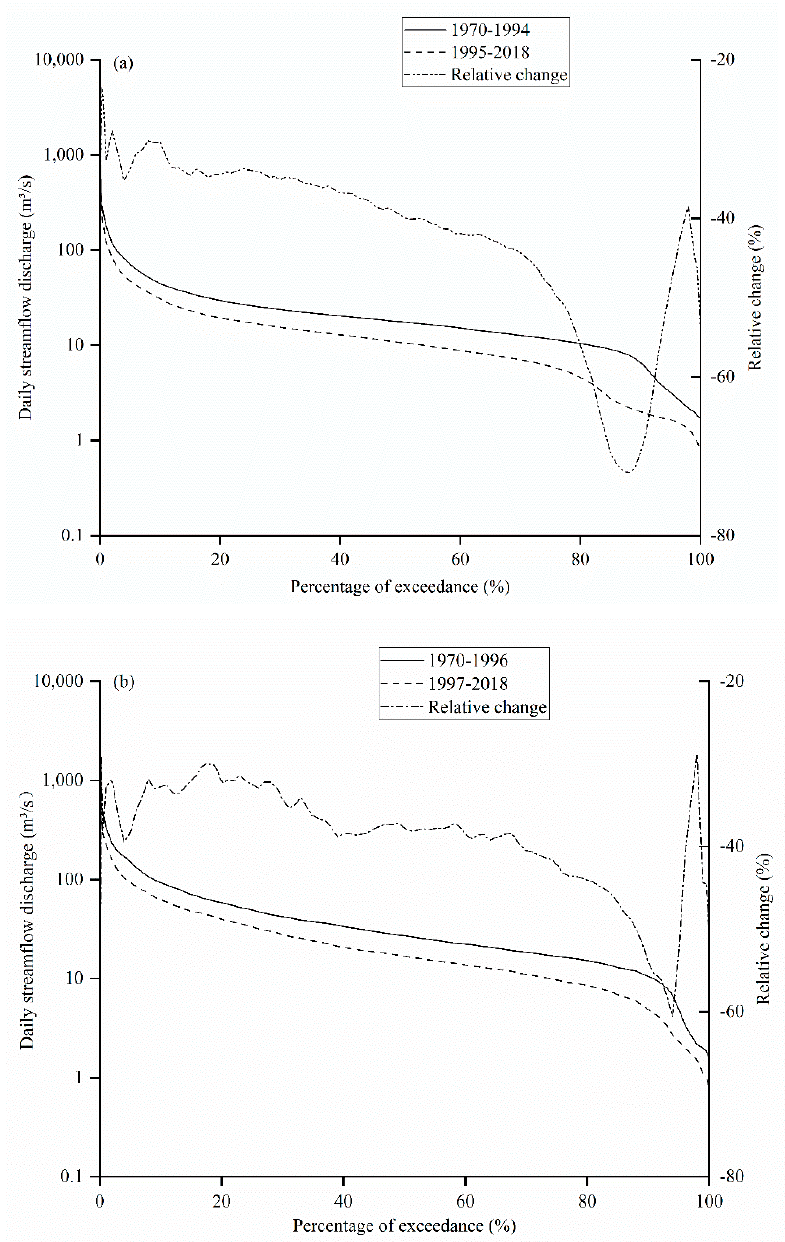
Figure 4. Comparison for ( a ) daily streamflow-duration curves of annual and ( b ) July–September in the Beiluo River Basin.